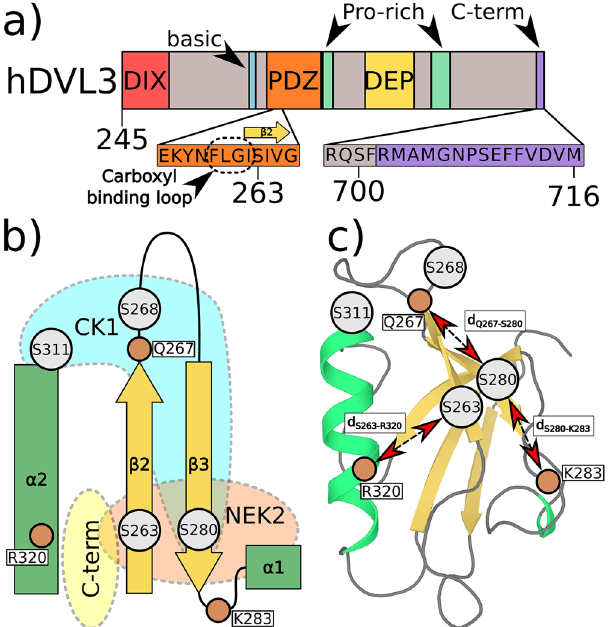
Figure 1. ( a ) Primary structure of the hDVL3 protein with position of PDZ and other domains/regions depicted. Amino acid sequences are shown for the C-term binding site and the C-terminus. ( b ) Schematic representation of the PDZ domain and its C-term binding site. The helix α 2 and two β -sheets the β 2 and the β 3 are shown. Positions of four phosphorylations sites and important residues interacting with phospho/mimetic variants are depicted with gray and brown circles, respectively. ( c ) Homology model of the hDVL3 PDZ domain based on the structure of the hDVL2 structure (PDB 2rey) with a secondary structure assignment based on the PDB 2rey. Distances between phosphorylation sites and important residues are depicted.